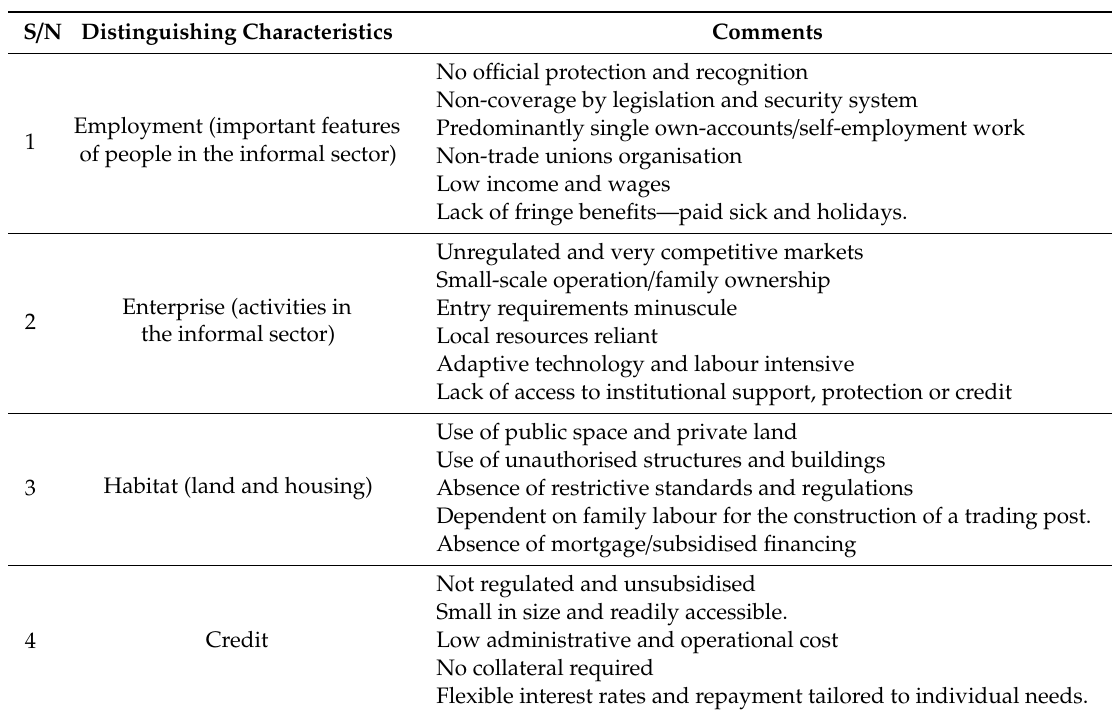
Table 4. Characterisation of the informal sector